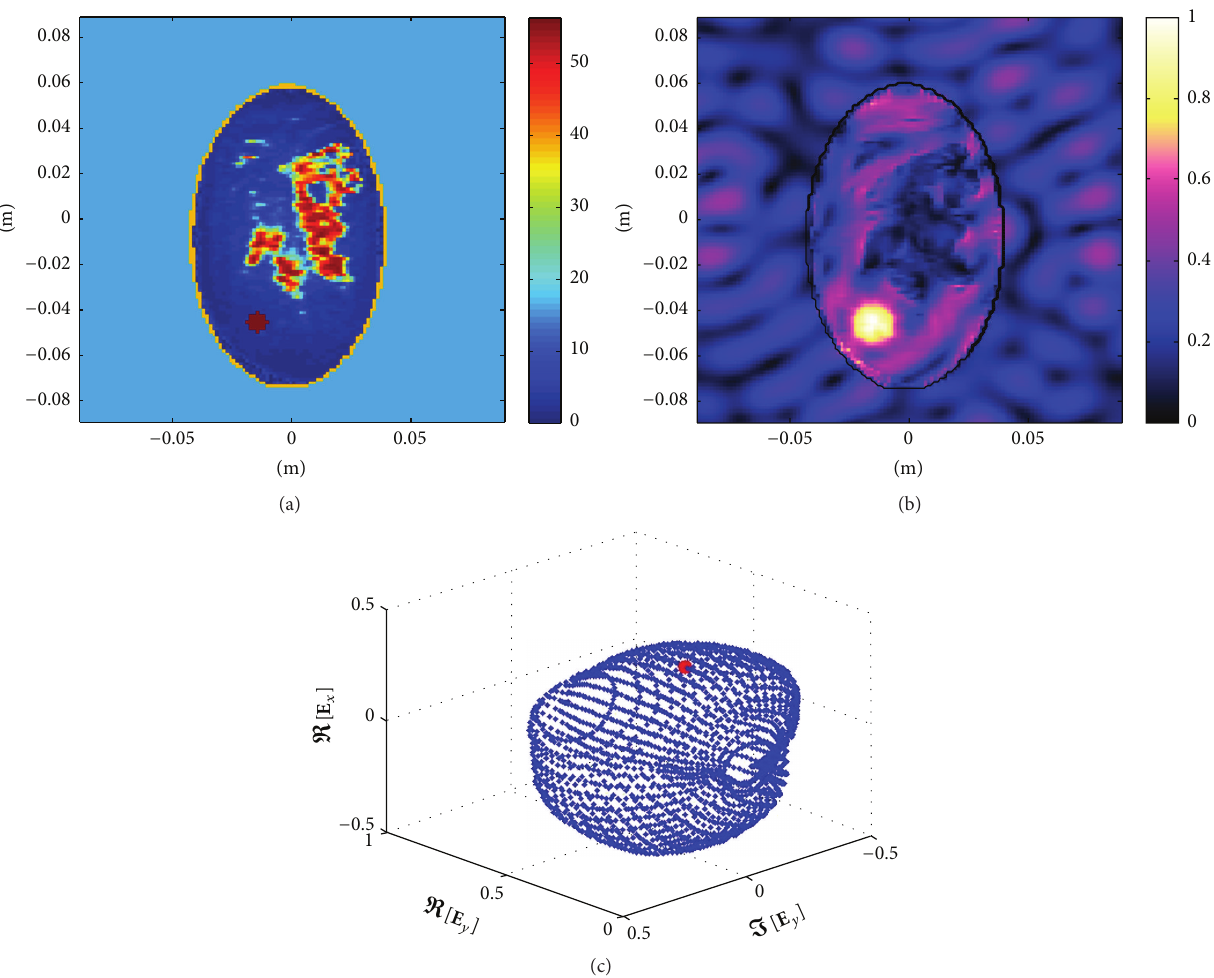
Figure 2: Focusing in a fatty breast phantom (slice 155, ID: 012304) [20, 21]: (a) permittivity profile, (b) intensity of the field | E (𝑟)| focused into the tumor, and (c) polar plot of the optimal field intensity (i.e., 𝐹( p ) ), as a function of all possible polarizations p of the field into the target point performed by the corresponding optimal excitations set I = [𝐼 1 ,𝐼 2 ,...,𝐼 𝑛 ] . The red dot represents the polarization ( p = [0.7886,0.6149𝑒 −𝑗0.49𝜋 ] ) which provides the highest field intensity into the target point | E (𝑟